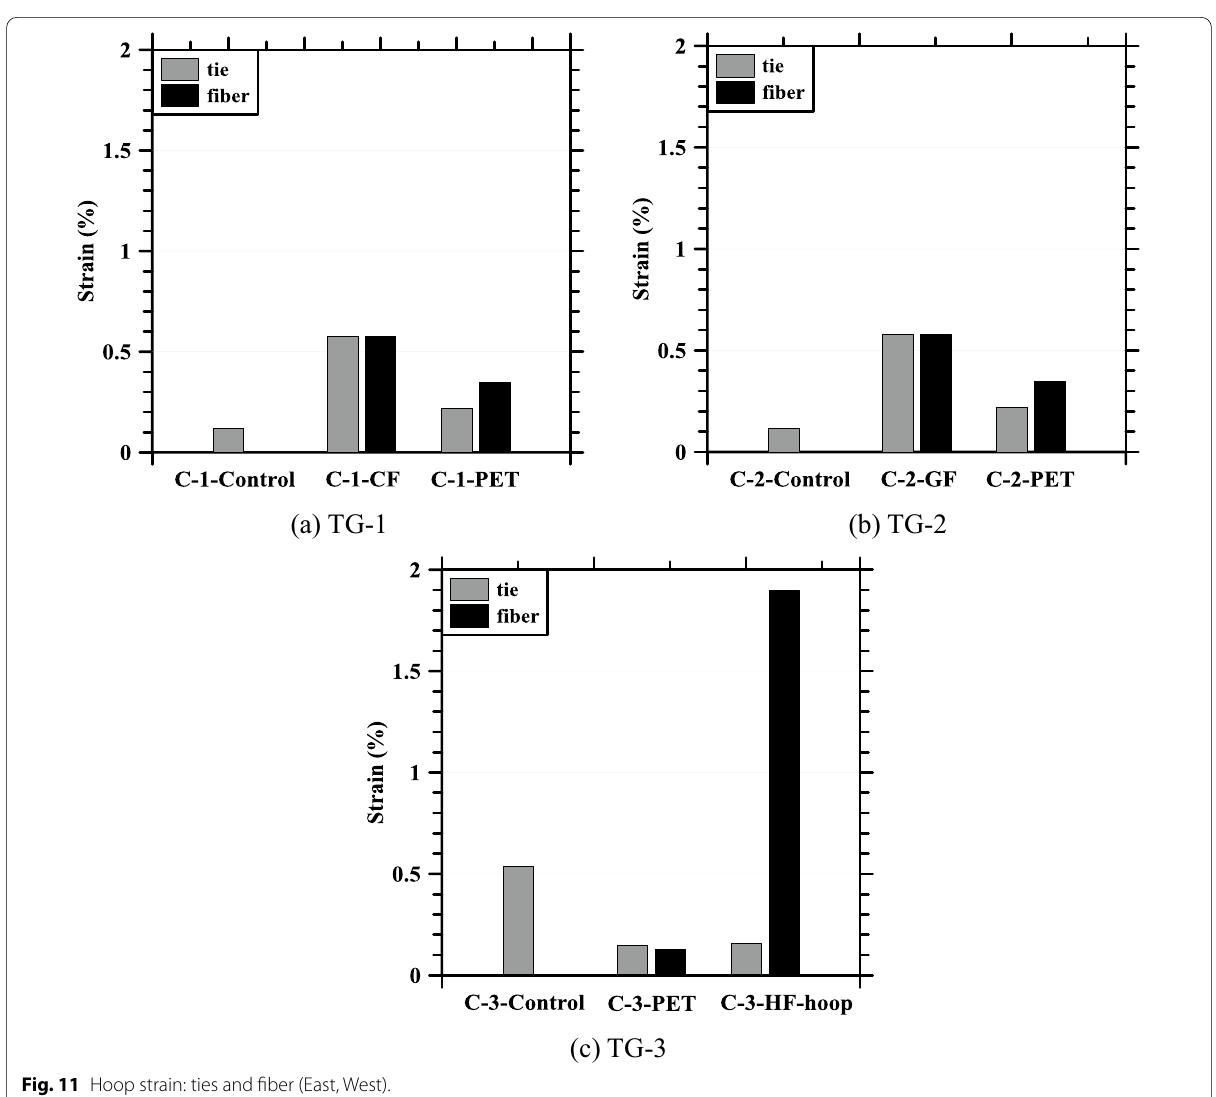
Fig. 11 Hoop strain: ties and fiber (East,